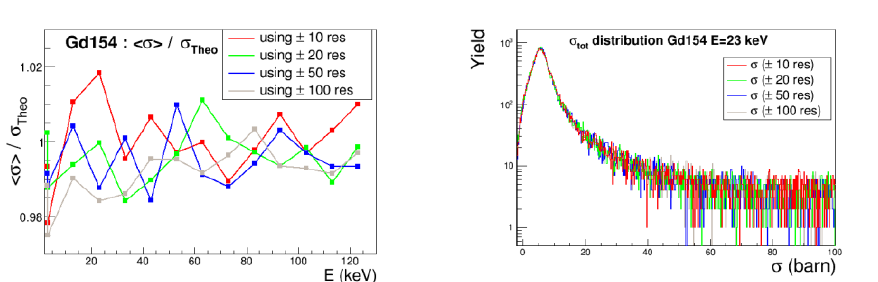
Fig. 4. 4a (left): Ratio between average total cross-section from 30,000 sets of resonances and theoretical cross-section using different number of resonances at 300 K. 4b (right): Histogram of 30,000 total cross-sections using different numbers of